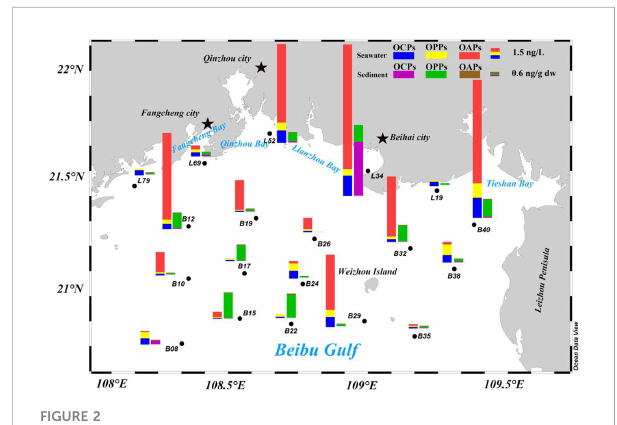
FIGURE 2 Concentration distributions of organochlorine pesticides (OCPs), organophosphorus pesticides (OPPs) and organic amine pesticides (OAPs) in seawater and surface sediments in Beibu Gulf. The bars represented the mean average cumulative pesticides values in seawater and sediment,